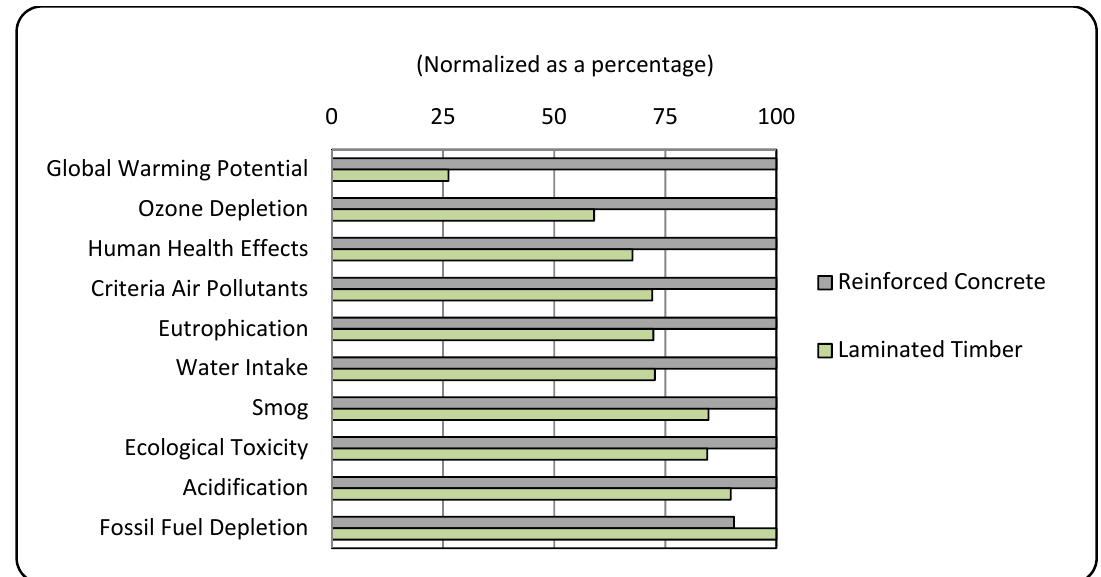
Figure 4. Comparative LCA results for a 10% increase in laminated timber